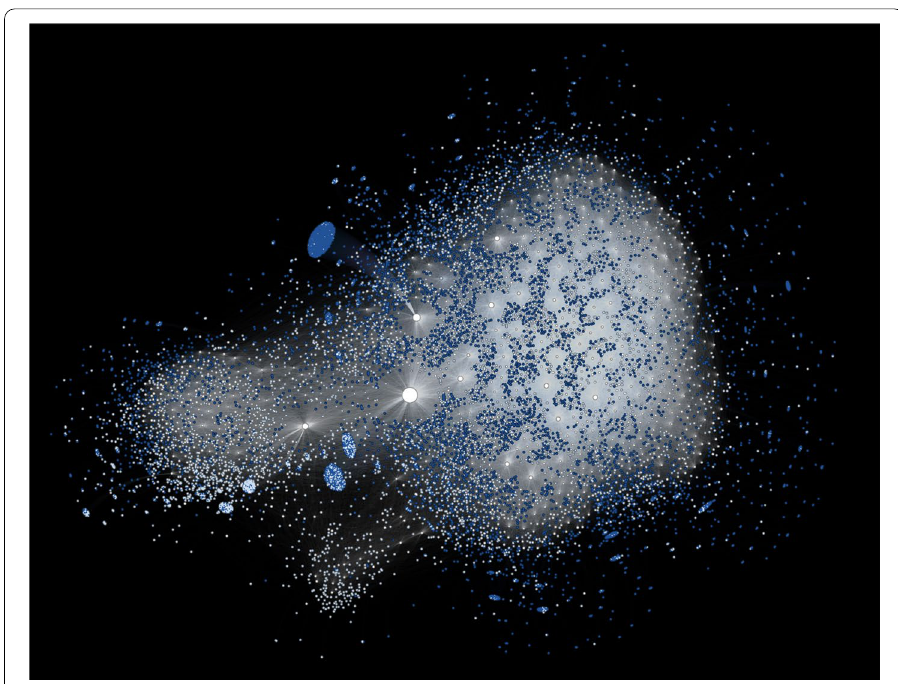
Fig. 2 Illustration of the E xpandEd -I nstancEs network. Node colors denote different types of instances: white and light blue indicate online and offline Mastodon instances, respectively, whereas dark blue corresponds to non-Mastodon instances. Node size is proportional to its degree. The displayed layout is based on the force-directed drawing ForceAtlas2 model. ( Produced by using the Graphistry service, available at https:// www. graph istry.